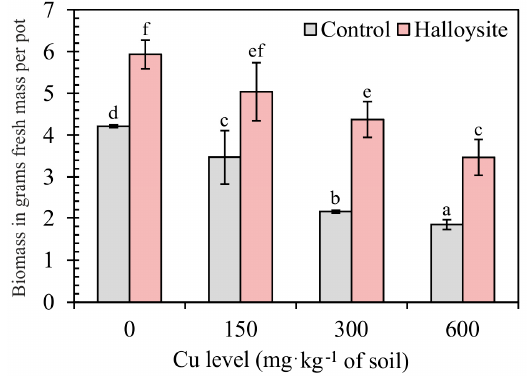
Figure 2. Effect of copper (Cu) and halloysite on the above-ground biomass of F. rubra in grams of fresh mass per pot. Error bars are ± standard error ( n = 3). Bars marked with different letters differ significantly for the same Cu exposure ( p < 0.05) according to the Duncan test.